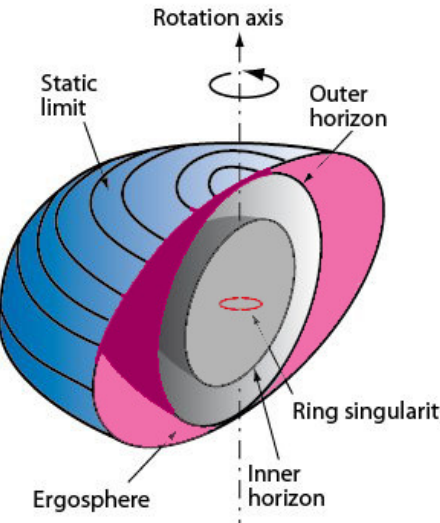
Figure 2. Schematic depiction of the black hole